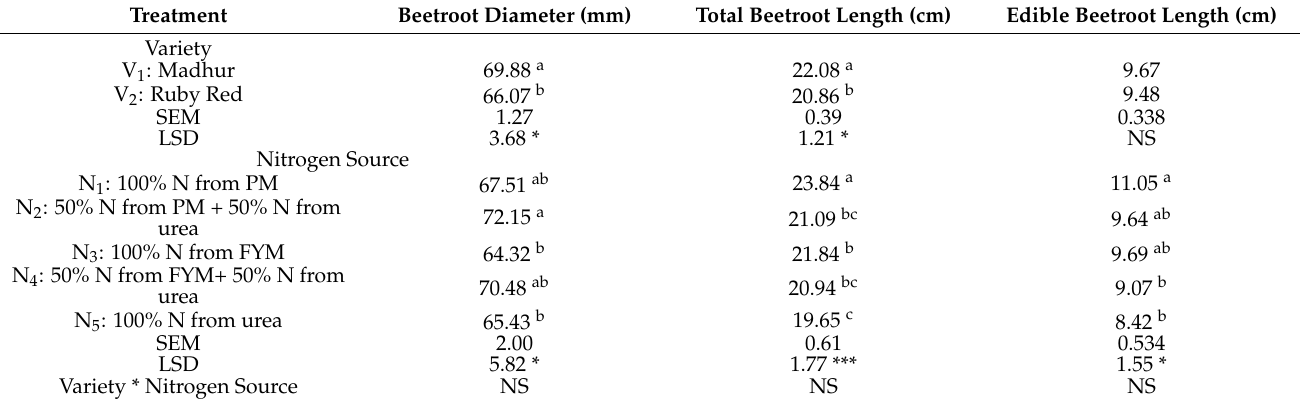
Table 6. Effect of variety and nitrogen source on beetroot diameter and length at AFU, Rampur, Chitwan in 2018/19. Treatment Beetroot Diameter (mm) Edible Beetroot Length (cm)